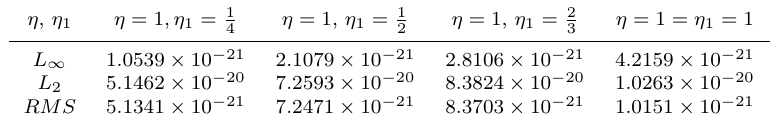
Table 2. The comparison of the L ∞ error, L 2 error and RMS obtained by our numerical method with m = m ′ = 1 and M = M ′ = 64 for different values for η 1 and η for Example